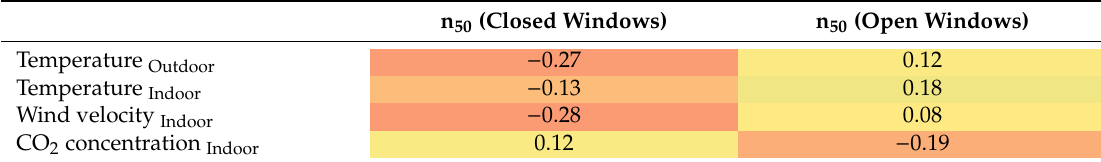
Table 7. Correlations between environmental parameters and n 50 .